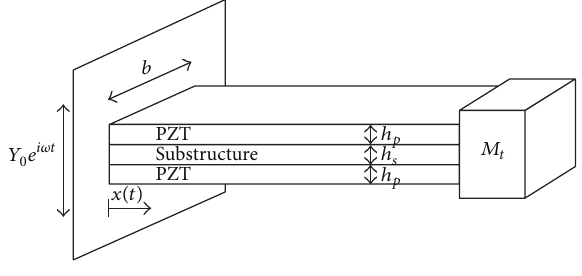
where 𝑤 rel (𝑥, 𝑡) is the transverse deflection of the beam relative to the base, 𝑤 𝑏 (𝑡) is the base displacement, 𝑀(𝑥, 𝑡) is the internal bending moment, 𝑐 𝑠 is the equivalent coefficient of strain rate damping, 𝑐 𝑎 is the viscous air damping, 𝐼 is the area moment of inertia of the cross section, 𝑚 is the mass per unit length, 𝑀 𝑡 is the tip mass, and 𝛿(𝑥) is the Dirac delta